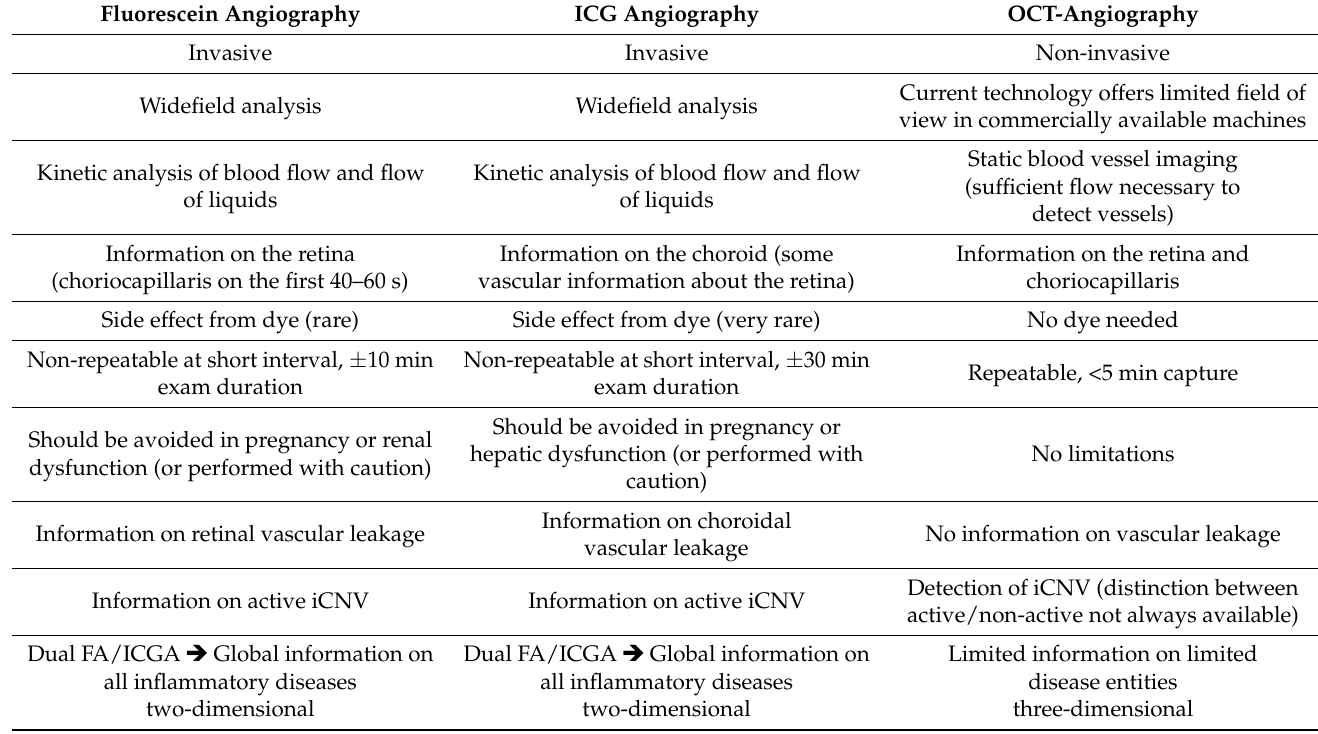
Table 1. Fluorescein angiography vs. ICGA angiography vs. OCT-A angiography.